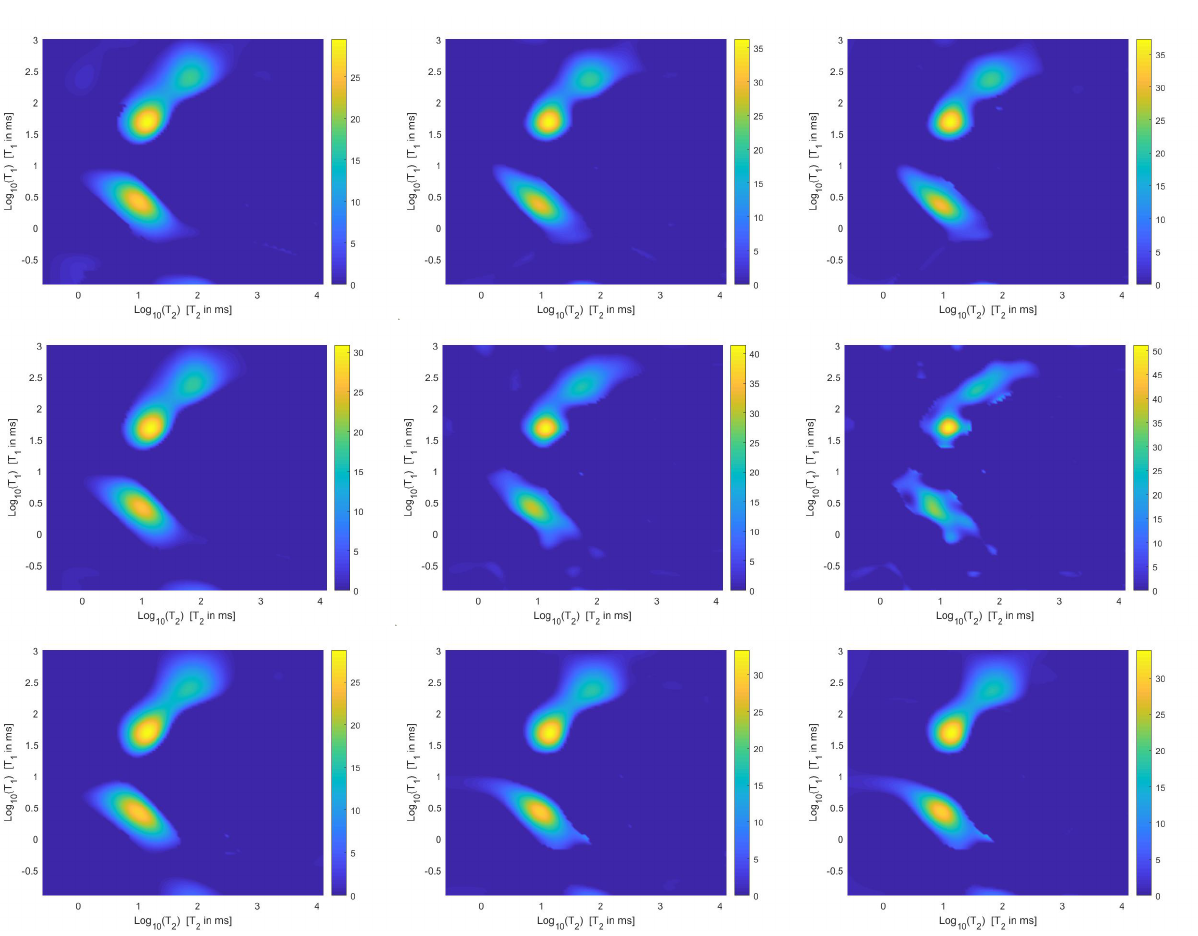
Figure 7. Estimated distributions from the Hybrid ( top row ), Tikhonov ( middle row ) and VSH ( bottom row ) models for α = 1 ( left column ), α = 10 − 2 ( middle column ) and α = 10 − 4 ( right column